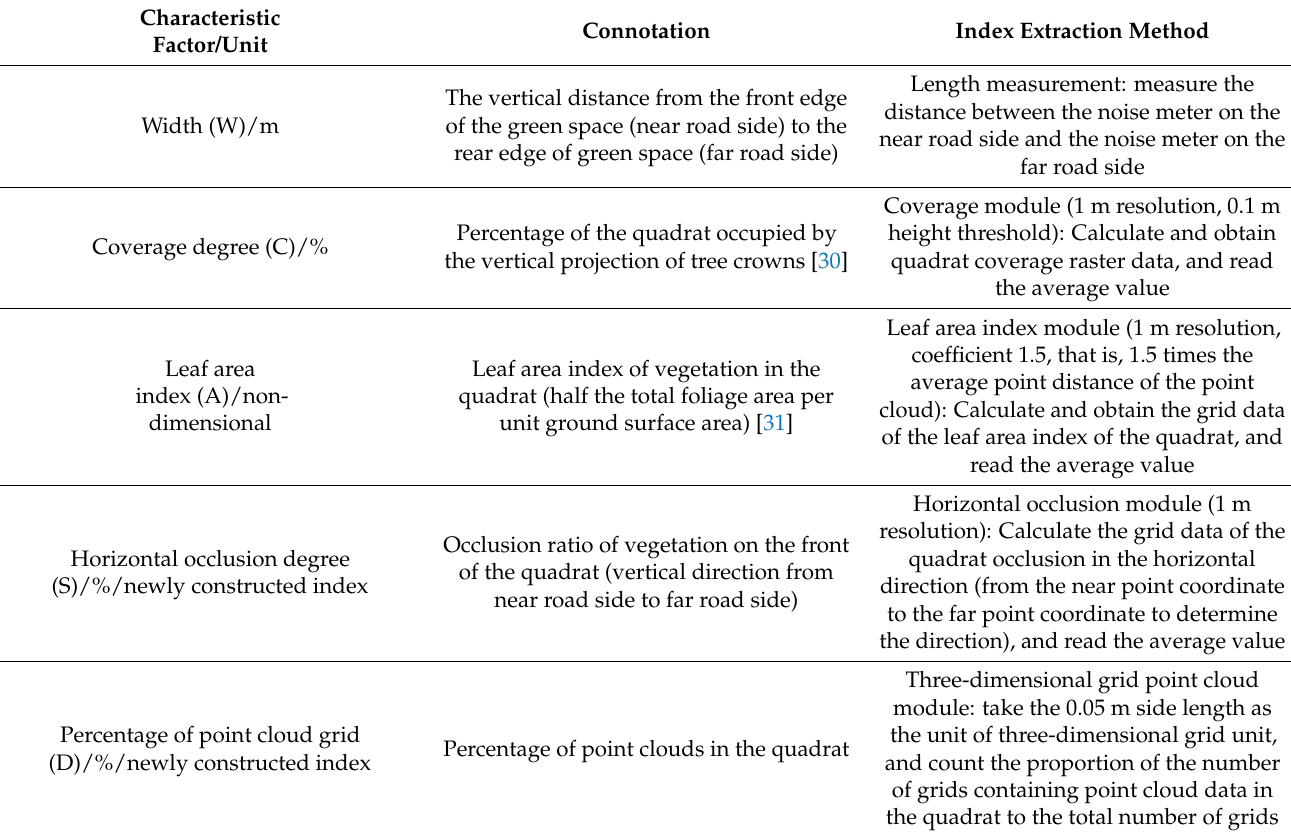
Table 2. Characteristic factor and index extraction method of